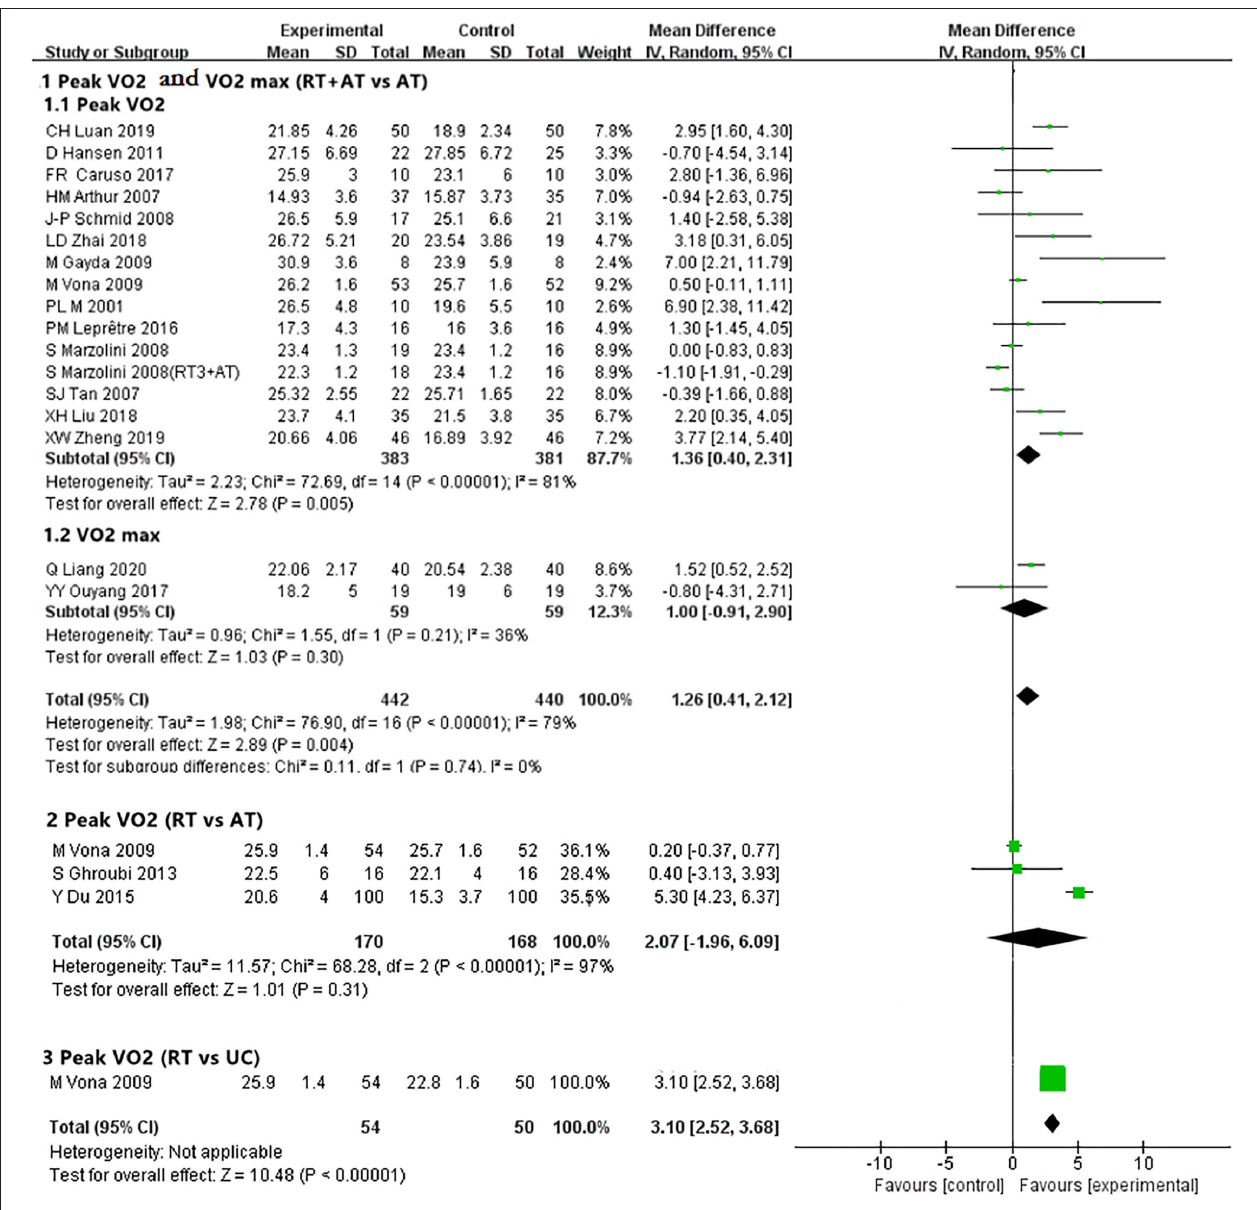
FIGURE 3 | Forest plot showing peak VO2 and VO2